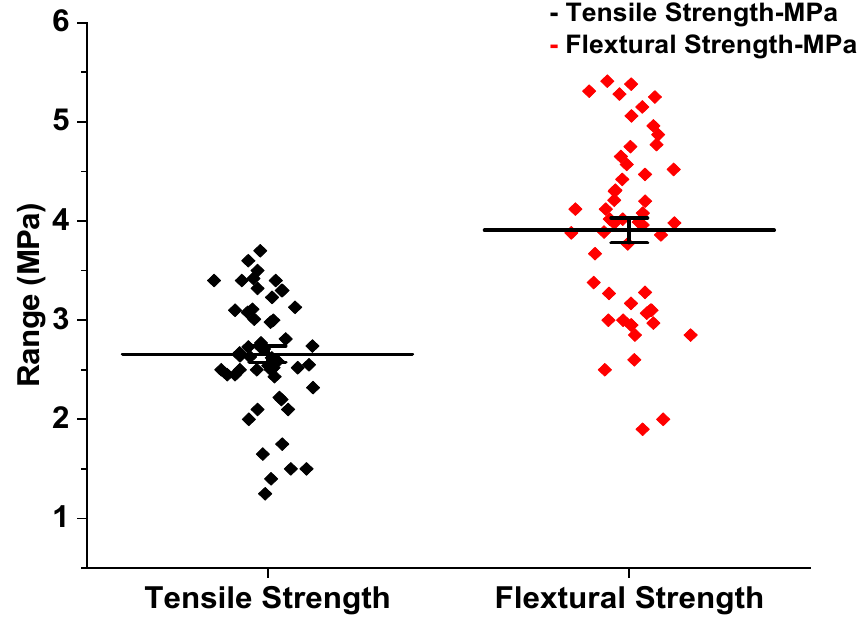
Figure 7. Scatter interval plot for STS (MPa) and FS (MPa).